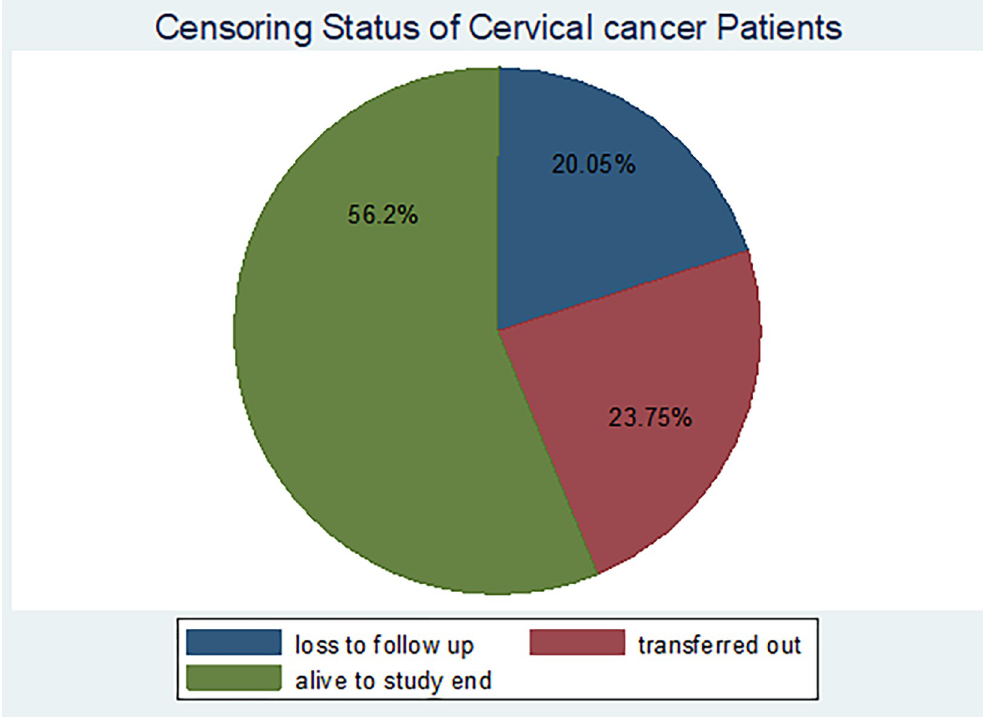
Fig 1. Censoring status of cervical cancer patients in Felege Hiwot Comprehensive Specialized Hospital oncology center, Ethiopia (n = 422, March 2021).